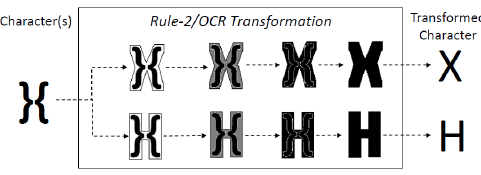
Figure 3. An example of a recognition